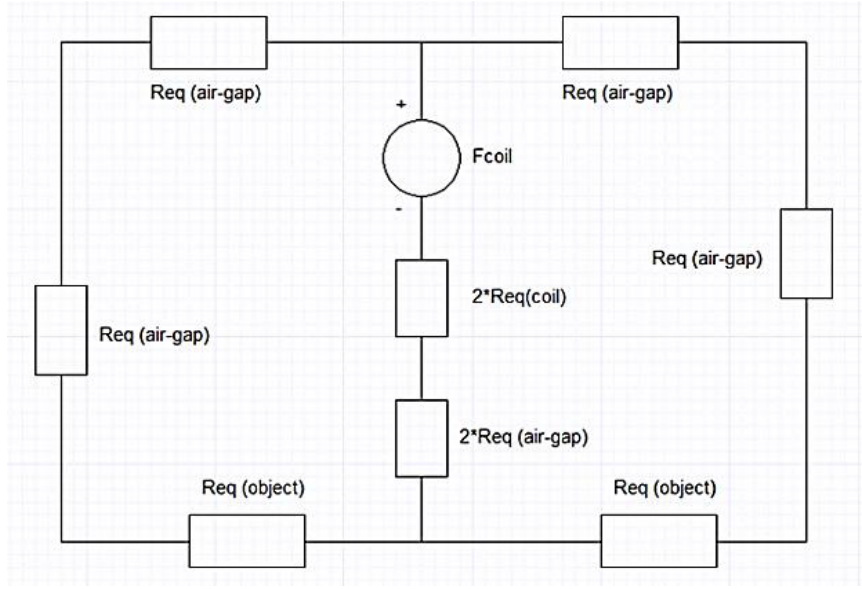
Figure 4. Magnetic Equivalent Circuit of MFEML for single coil